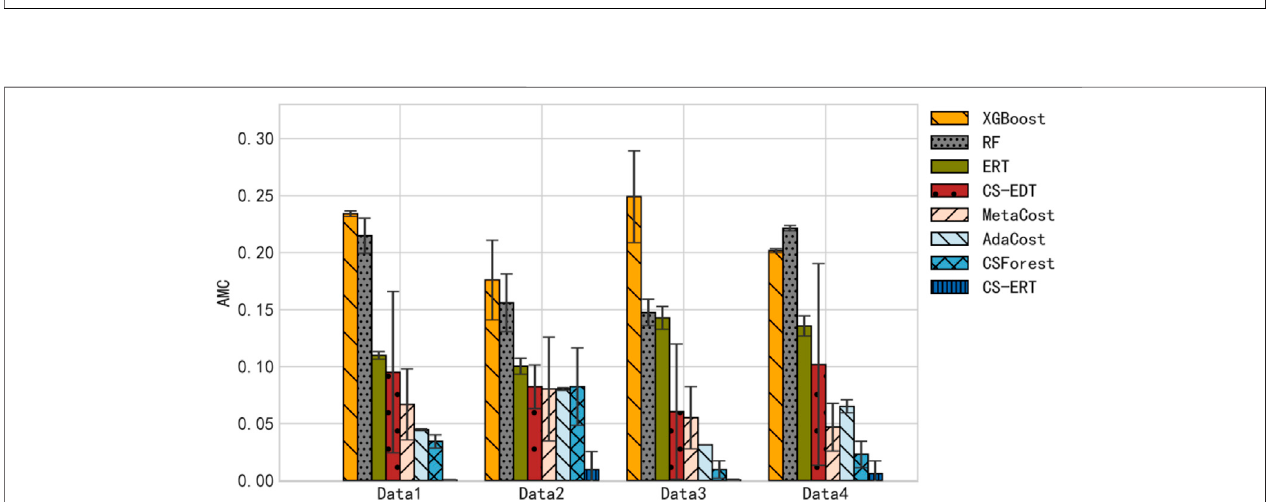
FIGURE 5 | Comparison of MDR for the eight algorithms on the four datasets.